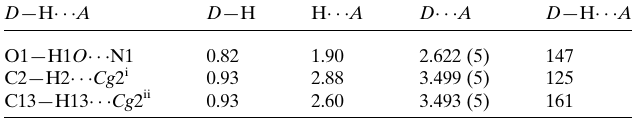
Table 1 Hydrogen-bond geometry (A˚ , (cid:3) ). Cg 2 is the centroid of the C5–C10 phenol ring.